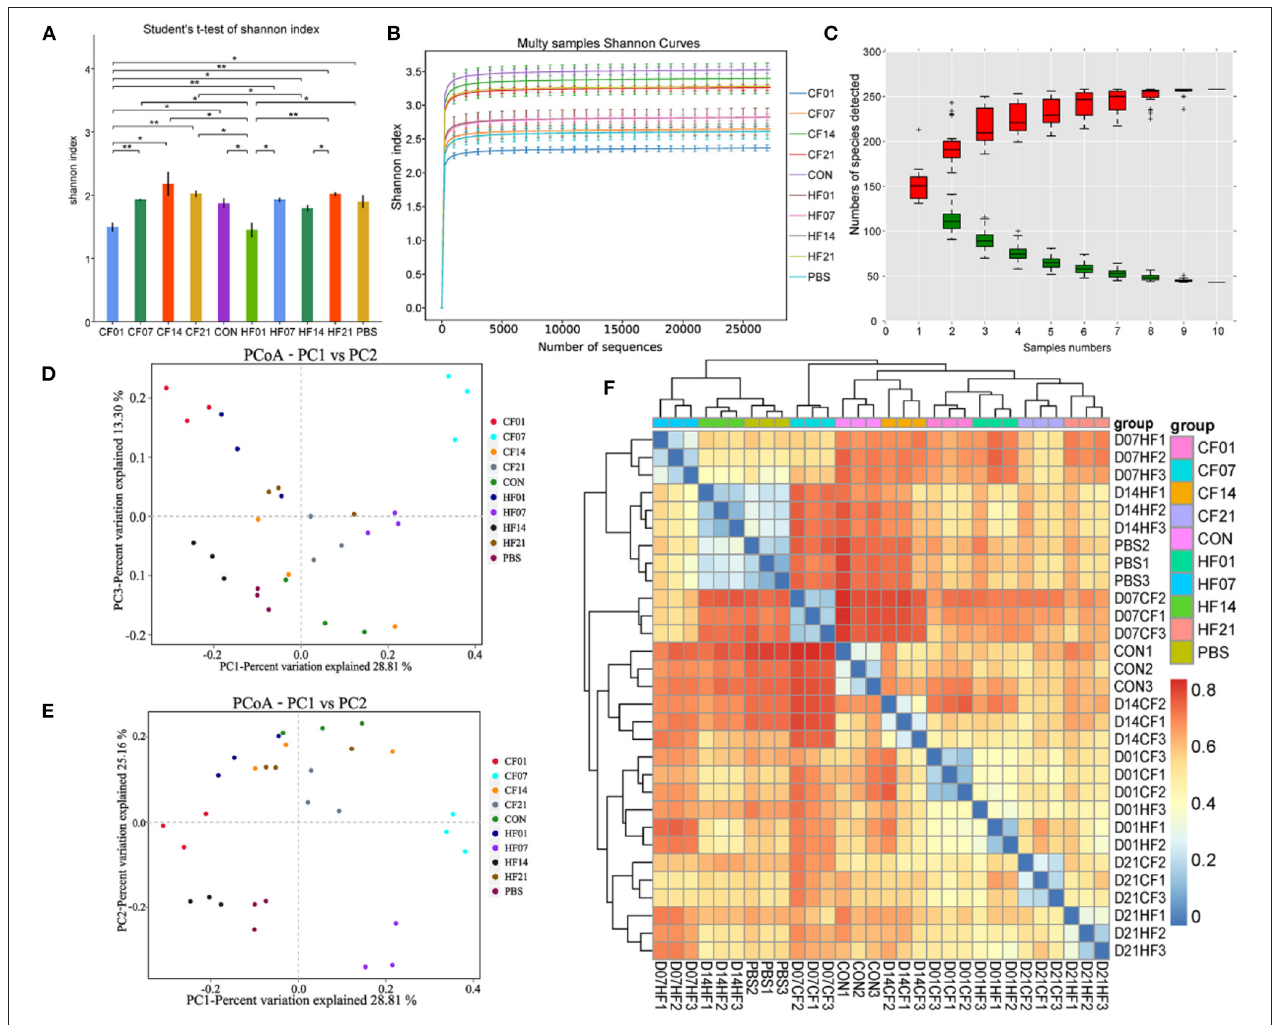
FIGURE 8 | Effects of heat stress on mice colonic microbiome. (A) Shannon Index plot; (B) Multy Shannon curves; (C) Species accumulation curves; (D,E) PCoA; (F) Heatmap of samples distance. CF & HF refer to infusion with feces from control– and HS animals, respectively; 1, 7, 14, and 21 refer to sampling days of pig feces and mouse transplantation. CF & HF refer to mice administered with feces from control– and HS pigs respectively. * P < 0.05, ** P < 0.01 compared with each